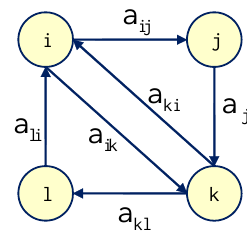
Figure 2. Cycles of length